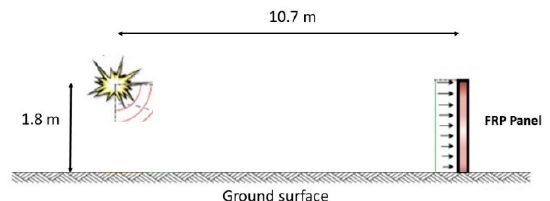
Figure 4. Schematic of experimental test. Adapted from [13] .